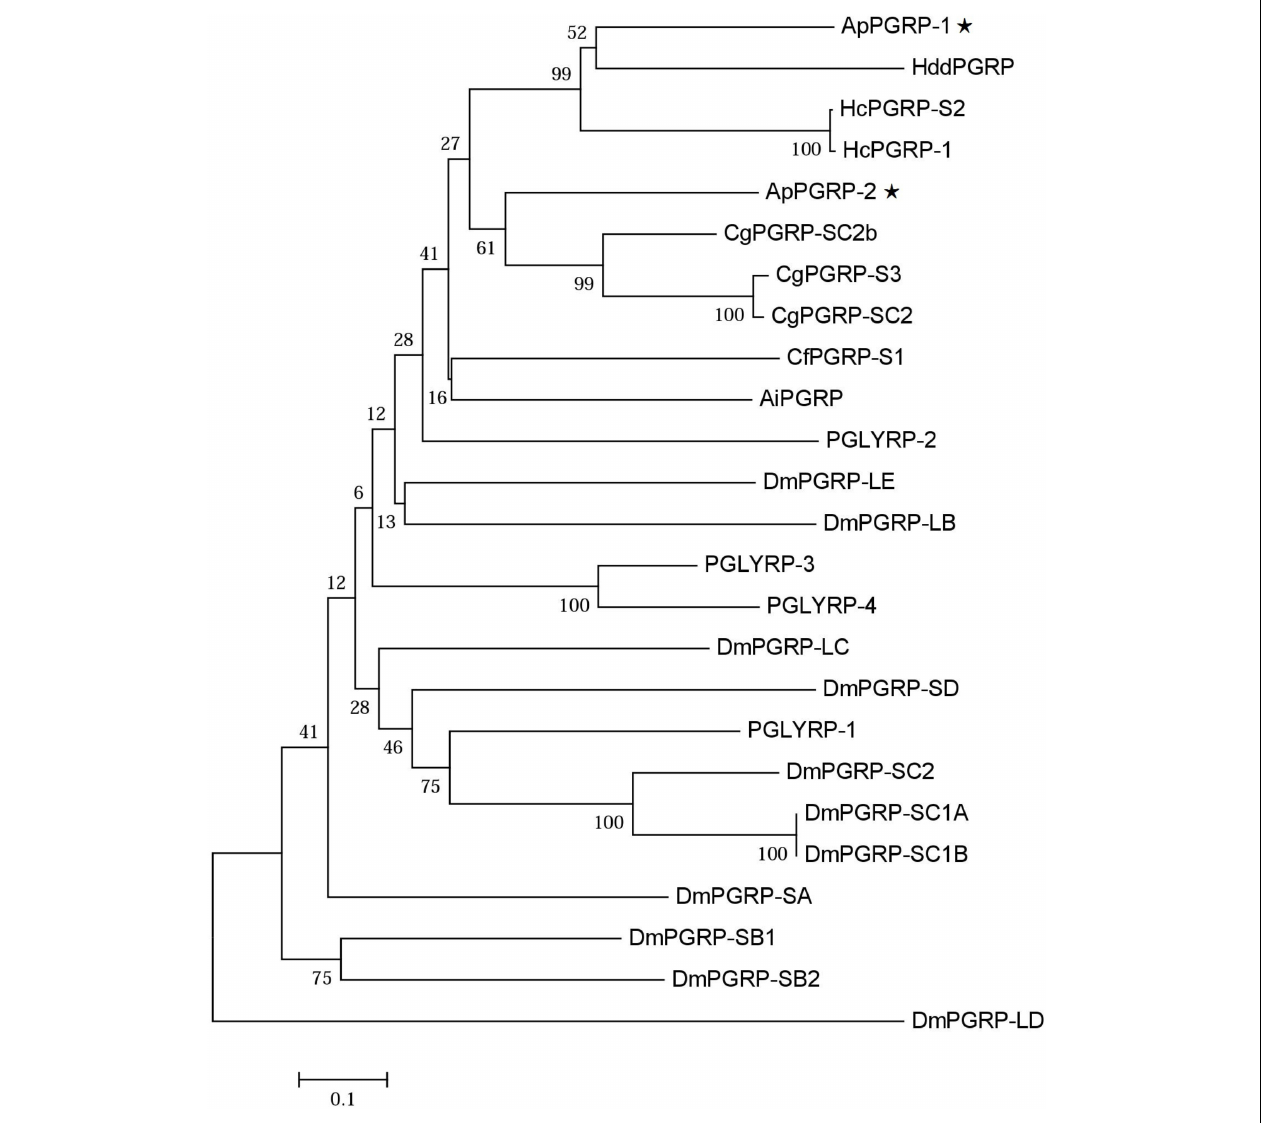
FIGURE 3 | Phylogenetic tree of ApPGRP-1 and ApPGRP-2 with other PGRPs. CgPGRP-SC2 (XP_011422762.1), CgPGRP-SC2b (XP_011422763.1), and CgPGRP-S3 (BAG31899.1) from C. gigas , CfPGRP-S1 (AAY53765) from Chlamys farreri , AiPGRP (AAR92030) from Argopecten irradians , HcPGRP-1 (AGU68334.1) and HcPGRP-S2 (AHK22786.1) from H. cumingi , HddPGRP (AHB30456.1) from Haliotis discus discus , DmPGRP-LE (AAF48519), -SA (AAF48056), -LF (NP_648299), -LBa (AAF54643), -LCa (NP_729468), -LDa (NP_001027113), -SC1a (CAD89163), -SC1b (CAD89164), -SD (CAD89198), -SC2 (CAD89178), -SB1 (CAD89129), -SB2 (CAD89140), and -LAa (AAK00295) from Drosophila melanogaster , PGLYRP-1 (O75594), PGLYRP-2 (Q96PD5), PGLYRP-3 (Q96LB9), and PGLYRP-4 (Q96LB8) from Homo sapiens . The tree was established using the neighbor-joining (NJ) method using the Mega7.0 program based on coding sequences. Bootstrap values of 1,000 replicates (%) are indicated for the branches. ApPGRPs are labeled with (cid:63)